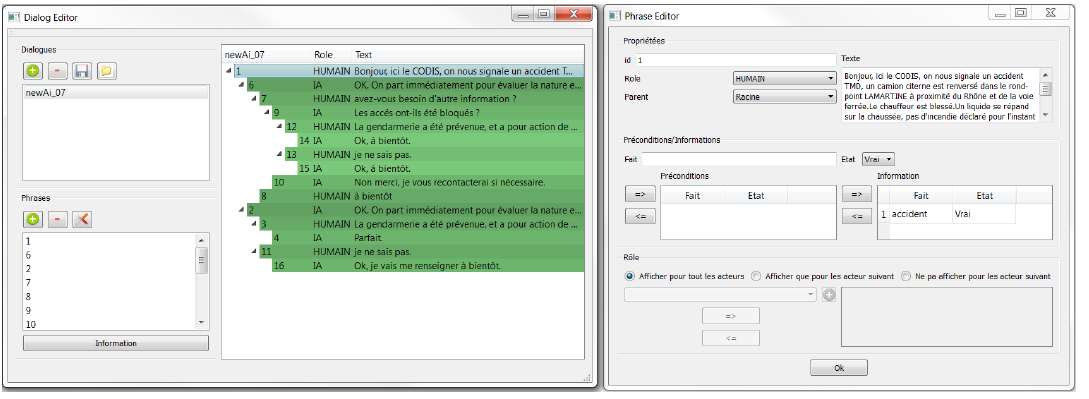
Figure 6. The dialogue and phrase edition.